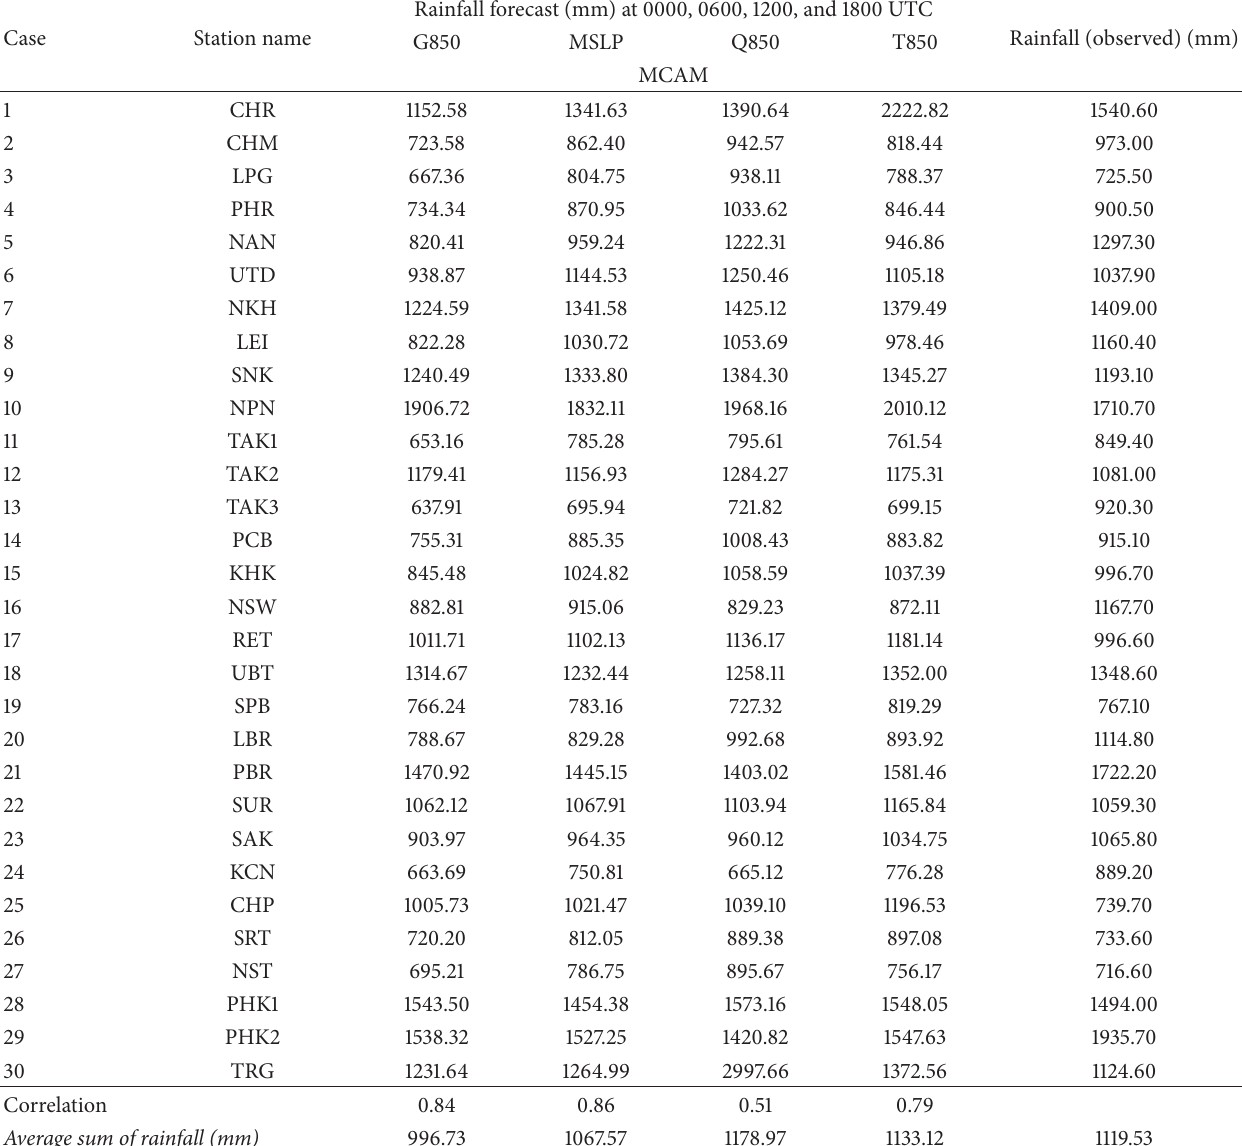
Table 6: Correlation between observed rainfall from predictors by using the MCAM taking into account the atmospheric predictors over Forecasts are for the months during 15 May to 15 October 2010 at the 30 TMD stations in